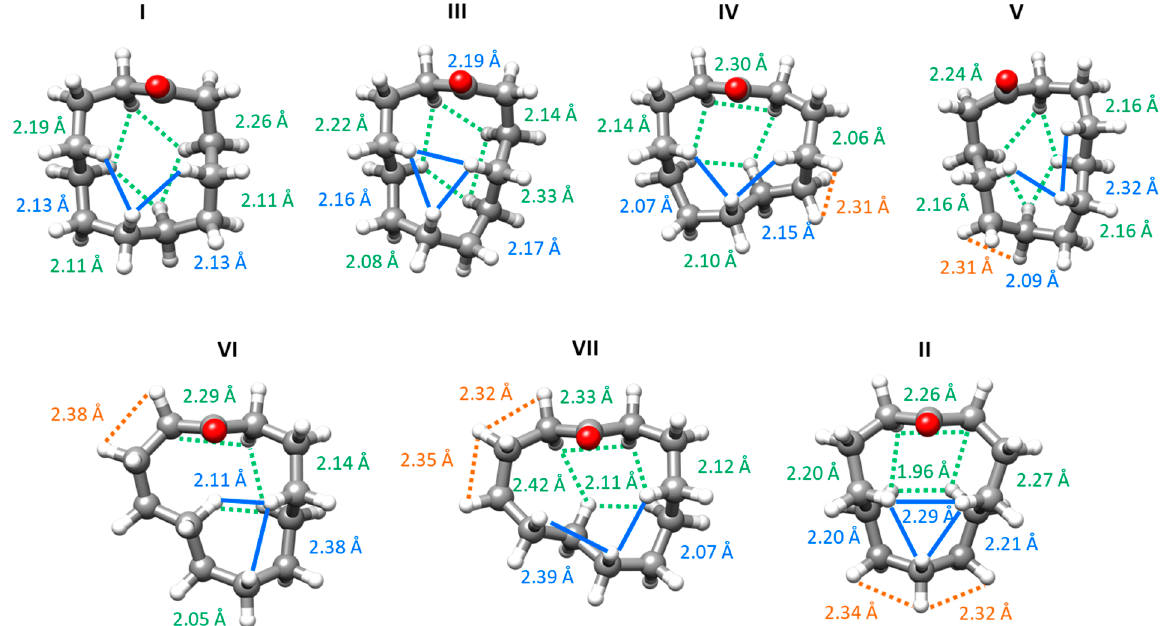
Figure 3. Observed conformers of cyclododecanone showing the transannular interactions, indicated in blue (above the ring, on the side of the carbonyl group) and green (below the ring, on the opposite side to the carbonyl group). The HCCH-eclipsed interactions are indicated in orange. The B3LYP-D3BJ values of the interaction distances are shown in close proximity to the corresponding interaction and in the same colour.